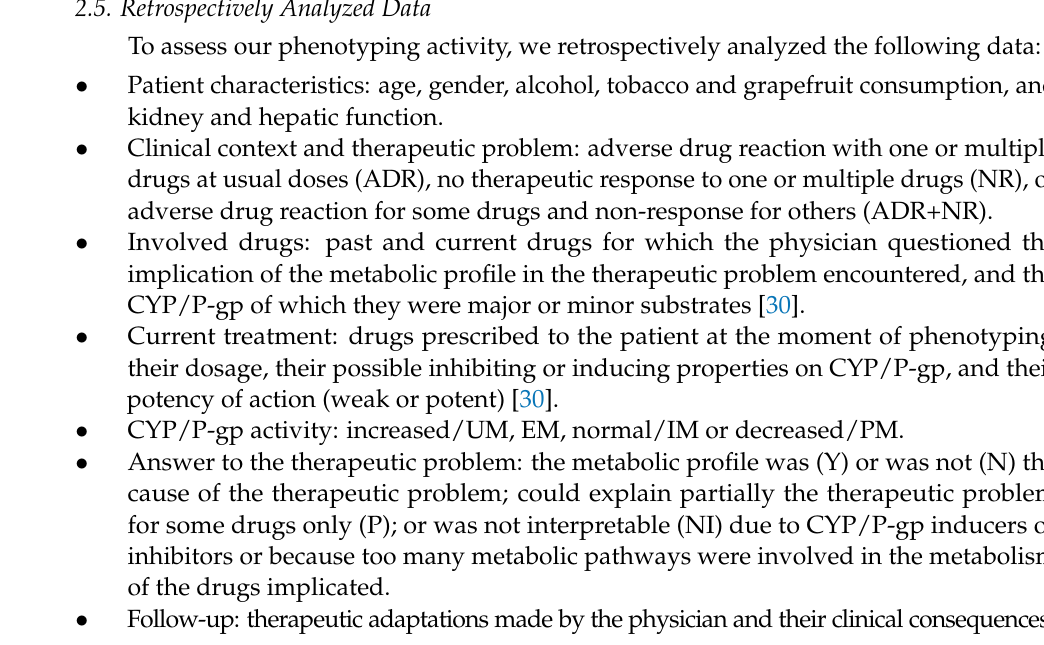
Figure 1. Phenotyping protocol.